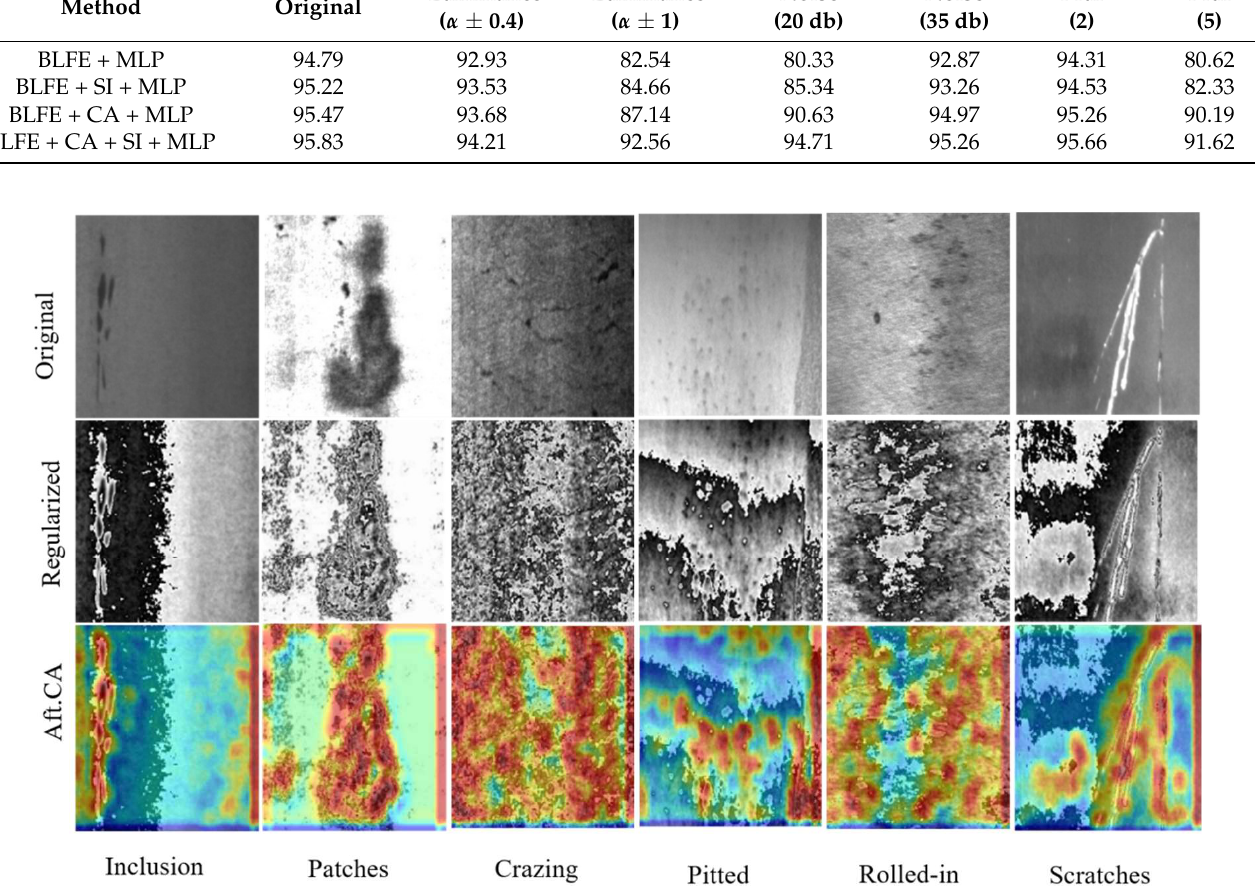
Figure 7. Visualization results of six typical surface defects of hot-rolled strip after being regularized and adding CA.